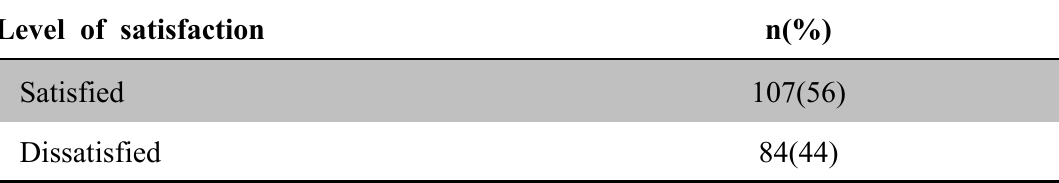
Table 3: Level of Satisfaction of Online Learning among Participants (n=191) Level of